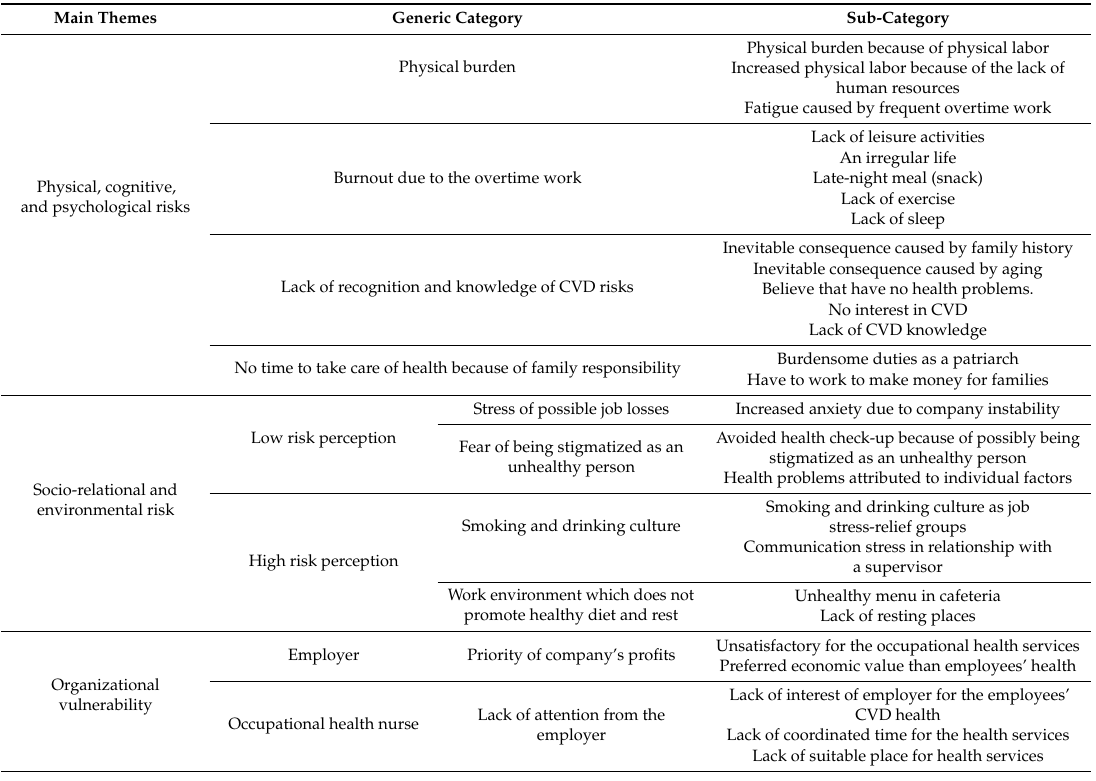
Table 3. Overview of categories and themes for CVD risk